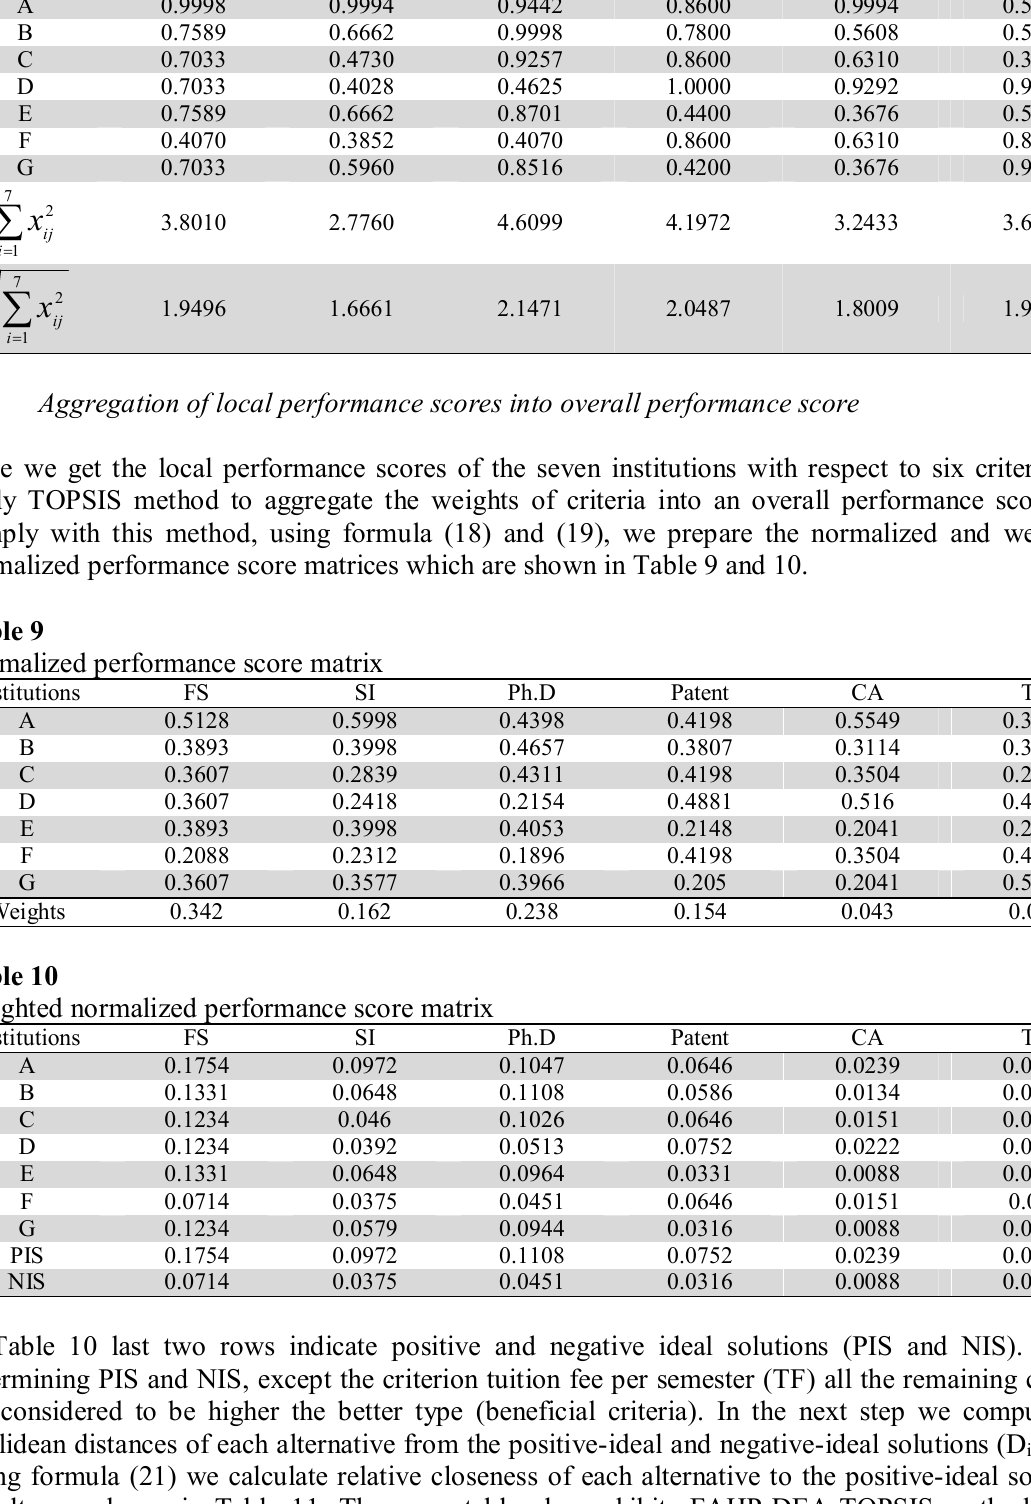
Local performance score matrix for 7 institutions Institutions